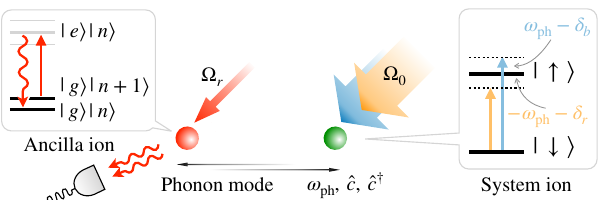
FIG. 6. Implementation of our criticality-enhanced sensing scheme in a trapped-ion setup. Two ions in a linear Paul trap share a collective phonon mode. The system ion is driven by bichromatic laser beams tuned close to the blue and red side- bands, realizing the Rabi Hamiltonian (15). The ancilla ion is subjected to weak sideband resolved laser cooling, of which the scattered photons are collected and counted continuously by a photon detector, effectively accomplishing continuous counting of the phonons (see the